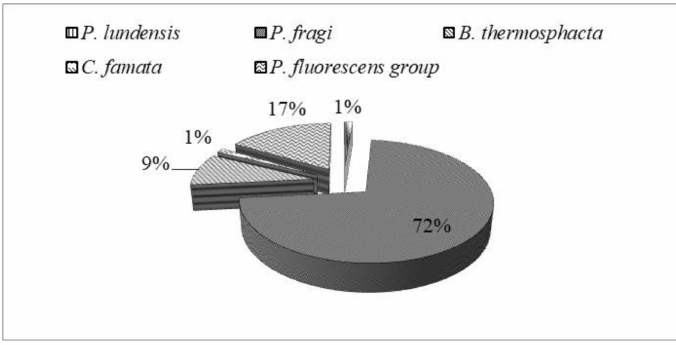
Figure 3. Occurrence (percentage, %) of dominant spoilage species in meat